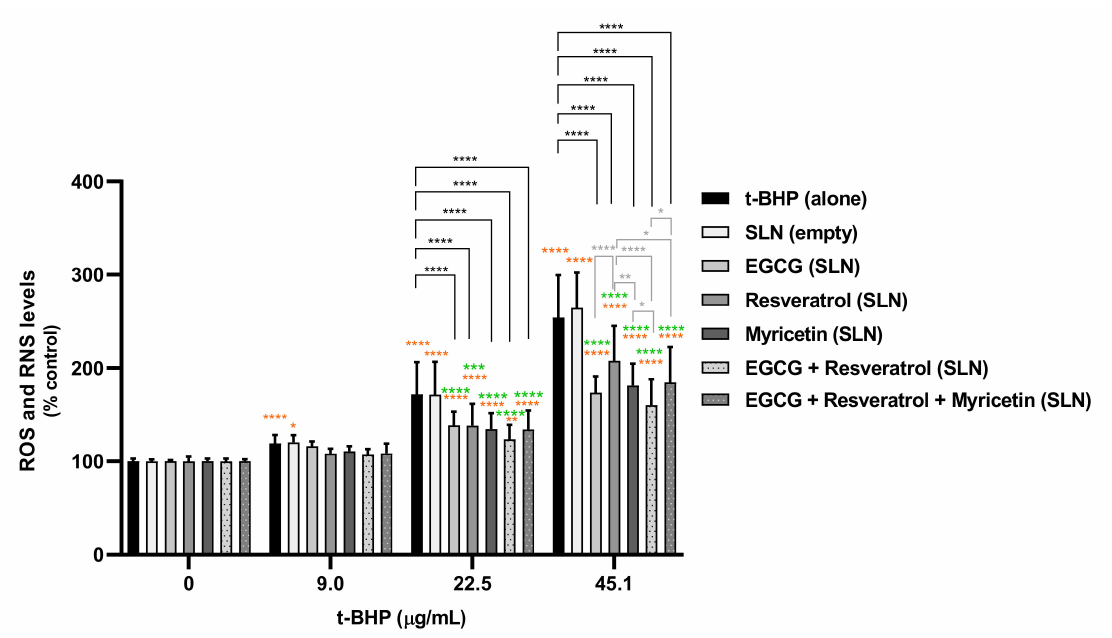
Figure 8. Intracellular levels of ROS/RNS evaluated in HaCaT cells 24 h after exposure to t-BHP (0–45.1 µ g/mL) in the presence or absence of the developed SLN formulations. Results are expressed as mean ± SD from six independent experiments performed in triplicate. Statistical comparisons were made using two-way ANOVA followed by Tukey’s multiple comparisons test (* p < 0.05, ** p < 0.01, *** p < 0.001; **** p < 0.0001; orange represents the statistical analysis for each condition versus 0 µ M t- BHP; green represents the statistical analysis at each t-BHP concentration for the comparison between NC-loaded SLN formulations and the unloaded SLN formulation; black represents the statistical analysis at each t-BHP concentration for the comparison between each SLN formulation and t-BHP alone; grey represents the statistical analysis at each t-BHP concentration for the comparison between the different NC-loaded SLN formulations). In all cases, p -values < 0.05 were considered